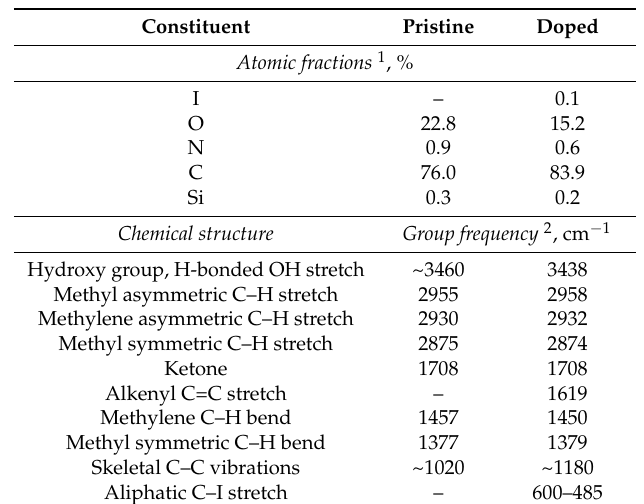
Table 1. X-ray photoelectron spectroscopy (XPS) and Fourier transform infrared spectroscopy (FTIR) characterization of pristine and iodine doped polyterpenol